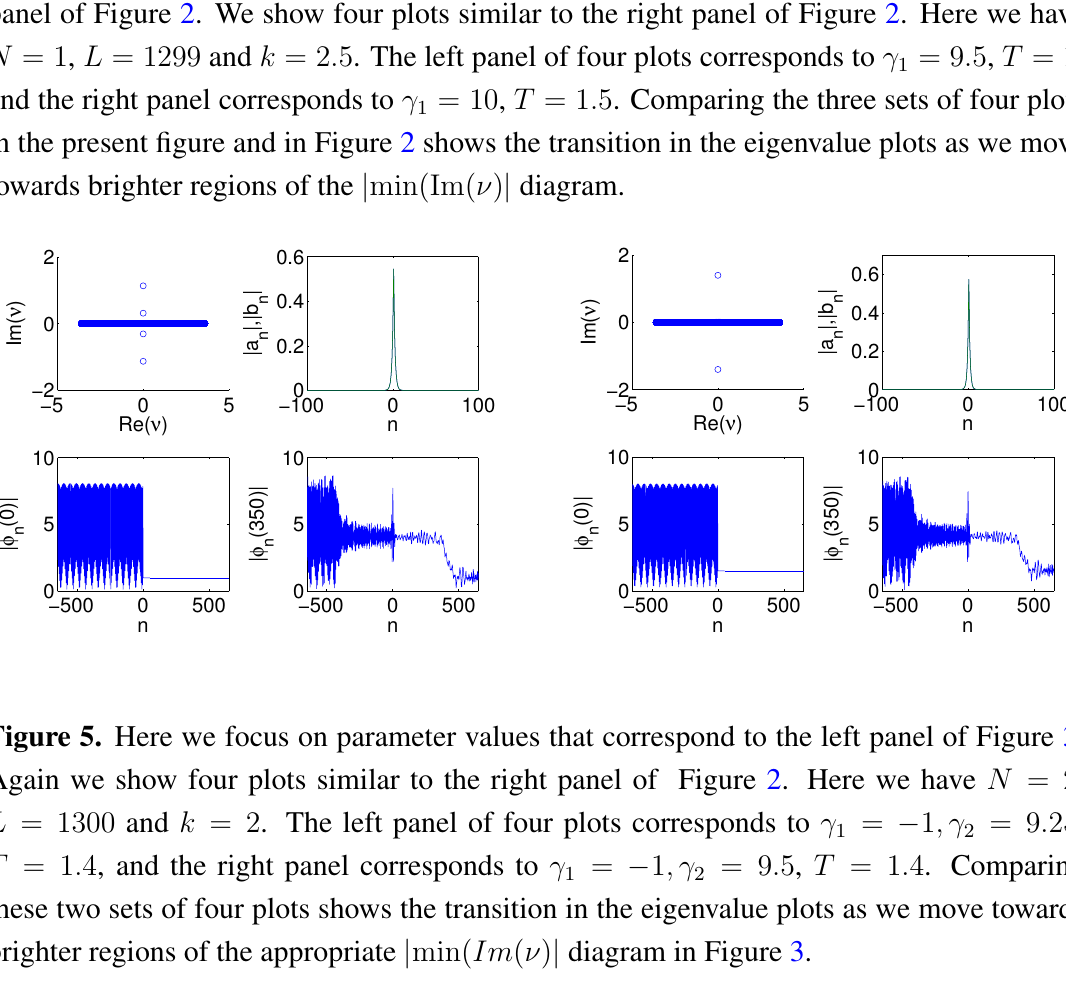
= − 1 , γ = 9 . 25 , 1 2 = − 1 , γ = 9 . 5 , T = 1 . 4 . Comparing 1 2